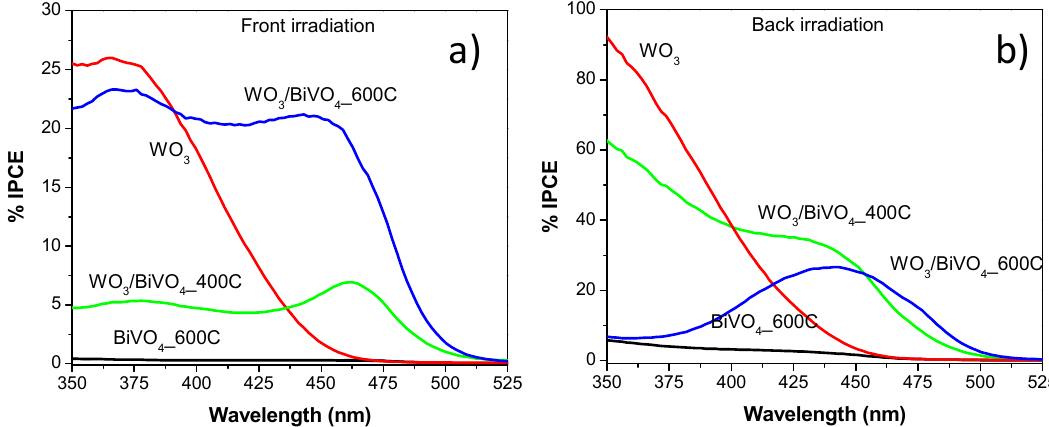
Figure 6. Incident photon to current efficiency (IPCE) curves recorded with WO 3 (red line), WO 3 /BiVO 4 _400C (green line), WO 3 /BiVO 4 _600C (blue line) and BiVO 4 _600C (black line) photoanodes under ( a ) front- and ( b ) back-side irradiation at 1.0 V vs. SCE in a 0.5 M Na 2 SO 4 electrolyte solution.